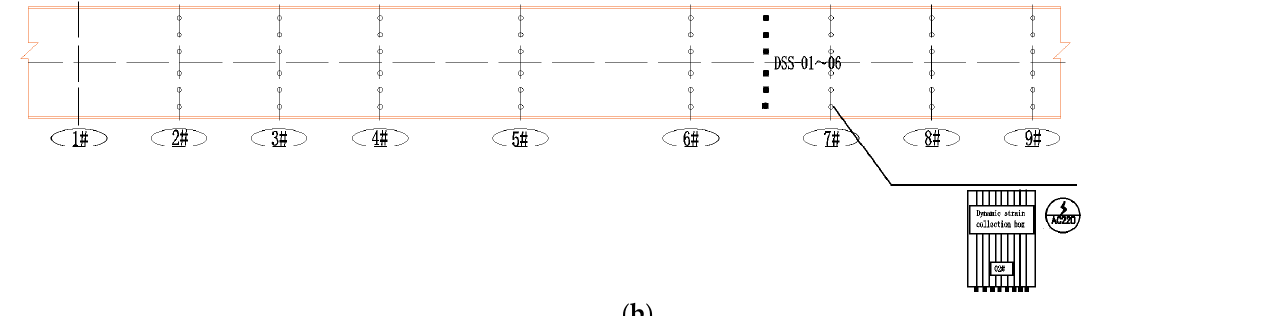
Figure 13. ( a ) Elevation layout of structural stress monitoring measurement points. ( b ) Plan layout of structural stress monitoring measurement points.